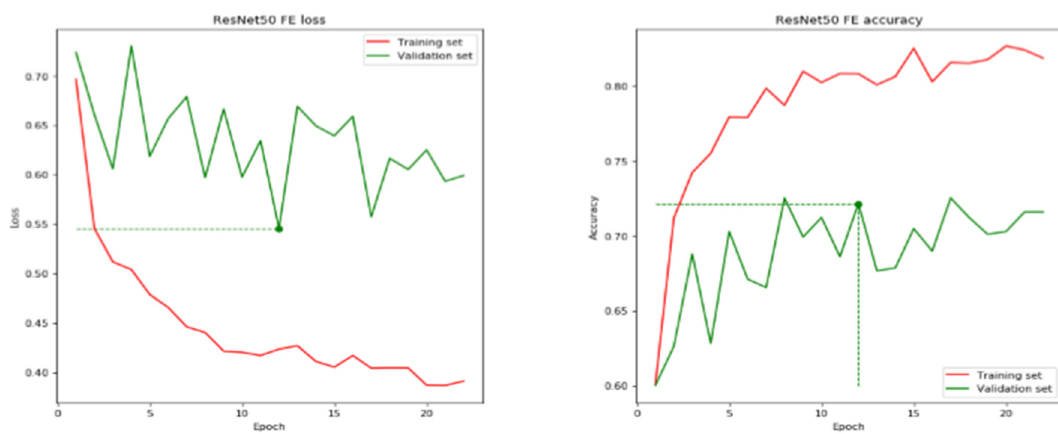
Figure 5. ResNet50 Feature Extraction.